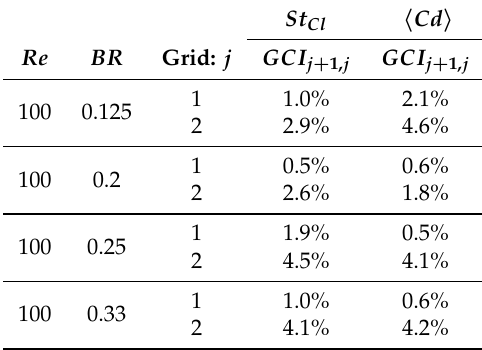
Table 1. Mesh convergence study ( GCI